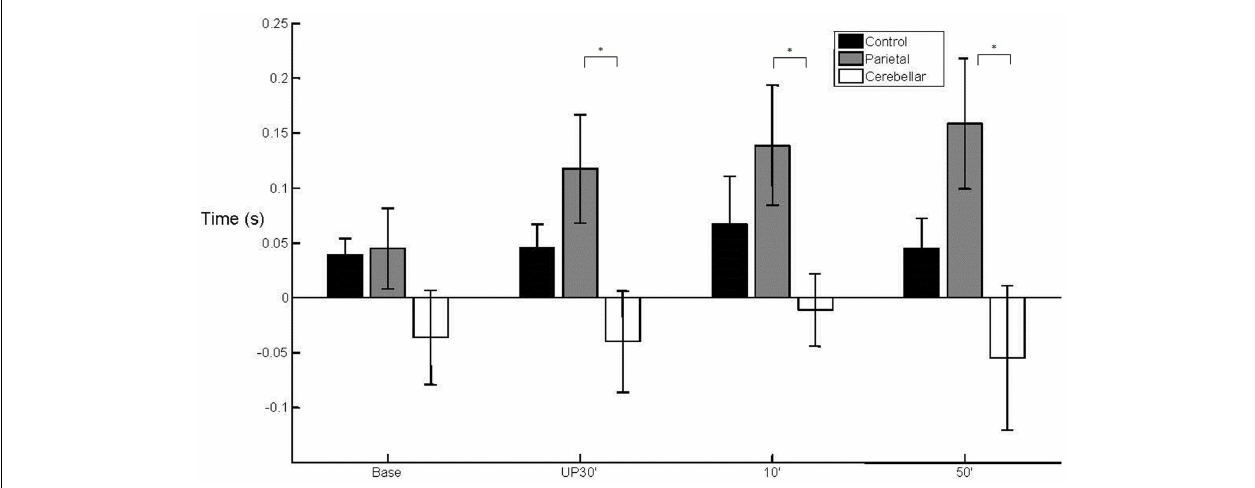
FIGURE 3 | Wrist path trajectory . Mean (SE) effect of group (control, parietal, and cerebellar) and condition (baseline, unperturbed 30°, perturbed 10°, and perturbed 50°).